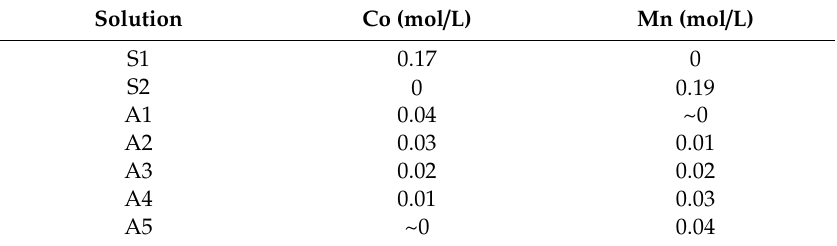
Table 3. Approximate composition of the precursor solutions and the “A” solutions to which they originated.